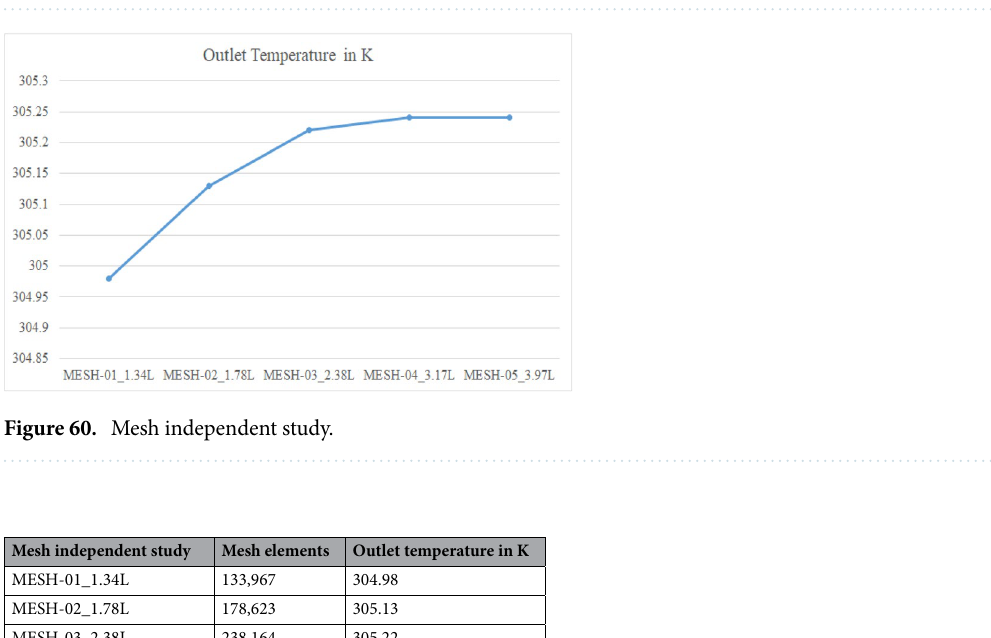
Figure 59. Schematic of vortex tube with grids of three-dimensional and cut section VT model.